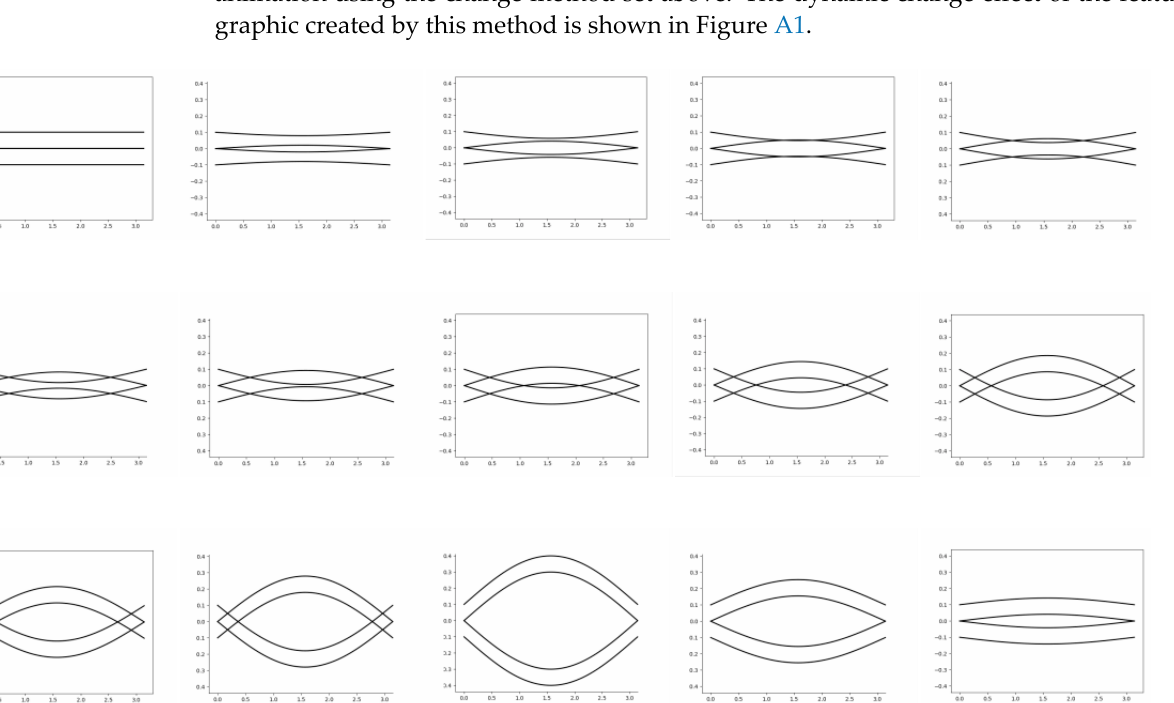
Figure A1. Dynamic change effect of the double‑arc feature graphic.